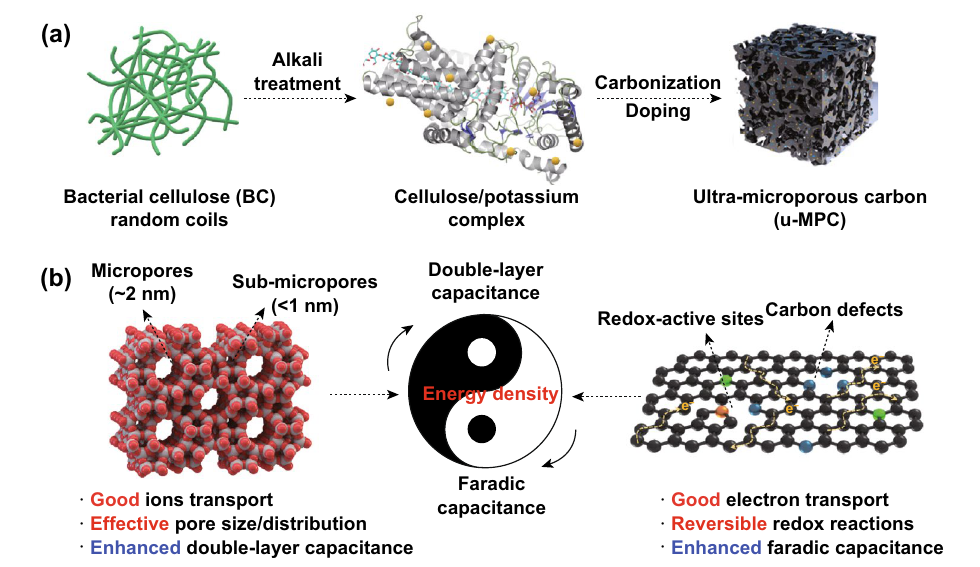
Fig. 1 Fabrication of u‑MPC and enhancement mechanism on energy density. a Schematic illustration for the fabrication of u‑MPC. b Sche‑ matic diagram of the enhancements of pore structure and carbonaceous constituent to energy